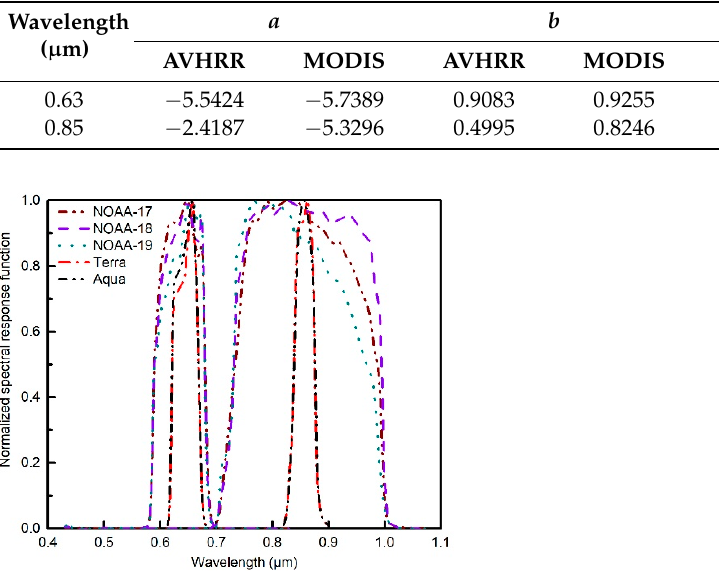
Figure 2. Normalized spectral response functions of channels 1 and 2 for AVHRR/NOAA-17-19, MODIS/Terra, and MODIS/Aqua (https://www.star.nesdis.noaa.gov/smcd/GCC/instrInfo-srf.php).